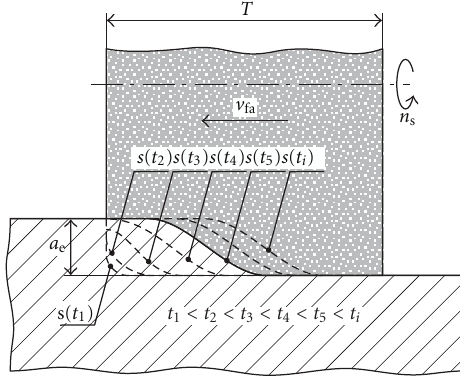
Figure 2: The e ff ects of wear upon the axial profile of a grinding wheel